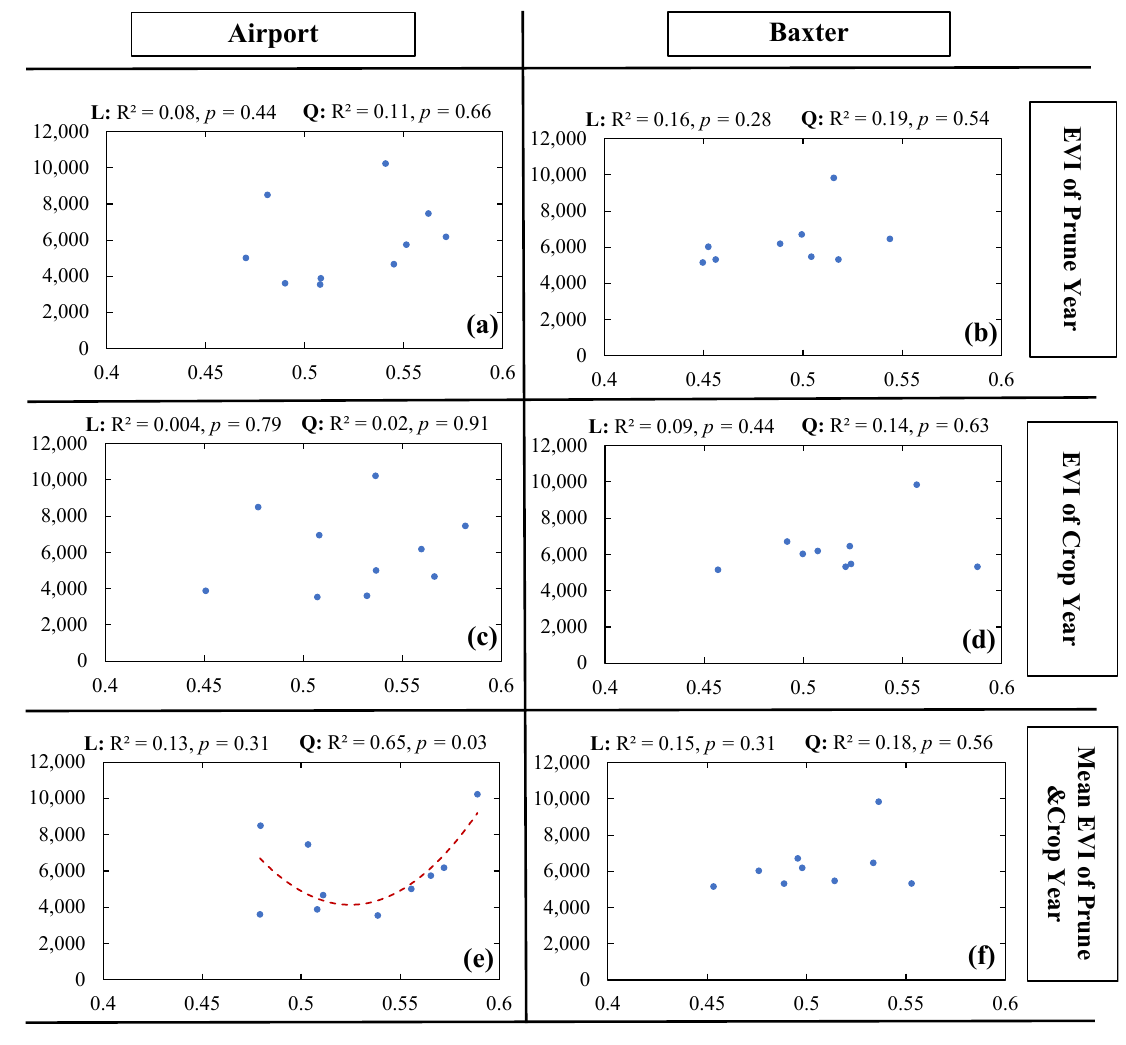
Figure 9. Relationship between wild blueberry yield (lbs./acre) and the average enhanced vegetation index (EVI) of ( a , b ) the prune year, ( c , d ) the crop year, and ( e , f ) the average of the prune and crop year from the Airport (irrigated) and Baxter (non-irrigated) fields in Deblois, Maine. The dashed red lines indicate significant ( p < 0.05) or marginally significant ( p < 0.10) quadratic relationships.